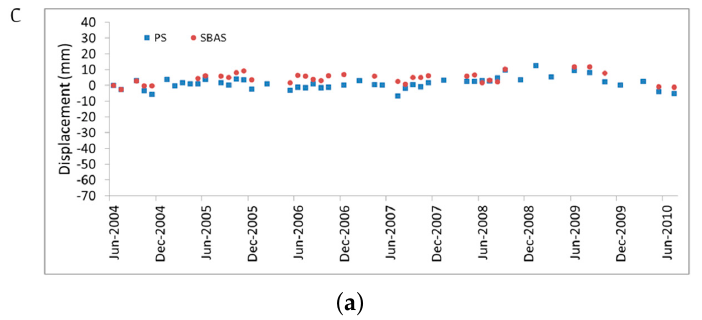
Figure 12. Comparison between the Envisat ascending ( A ) GPOD-SBAS results and ( B ) the PSInSAR results (from the Portale Cartografico Nazionale) over the Aosta municipality, considered as common stable area; ( C ) time series corresponding to the SBAS target and the Permanent Scatterers (PS), signified respectively by the black square in ( A ) and by the red square in ( B ).